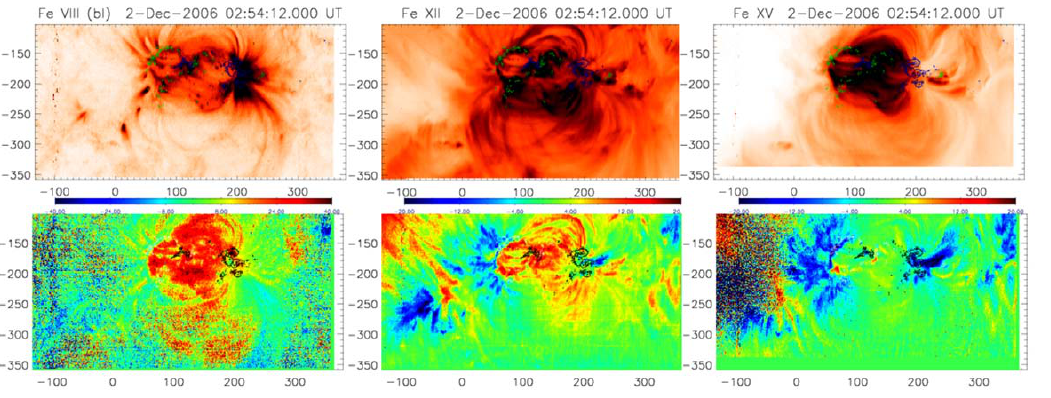
Figure 11: Monochromatic (negative) images and dopplergrams km s –1 ) of an active region (NOAA 10926) observed with Hinode/EIS in Fe viii , Fe xii , Fe xv lines. Courtesy of G. Del